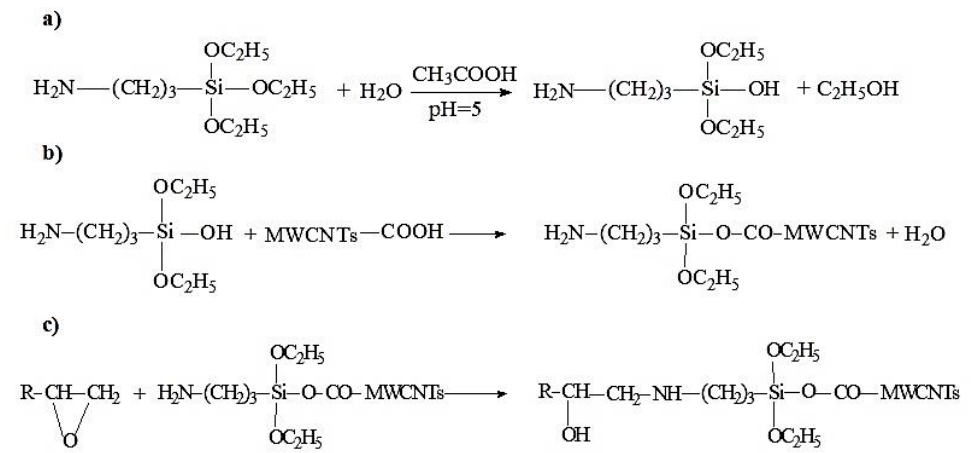
Figure 7. Chemistry of the interaction of epoxy oligomer ED-20, APTES and MWCNTs: ( a ) preparation of APTES solution in H 2 O; ( b ) chemical interaction of APTES and MWCNTs; ( c ) chemical interaction of APTES-treated MWCNTs with epoxy oligomer